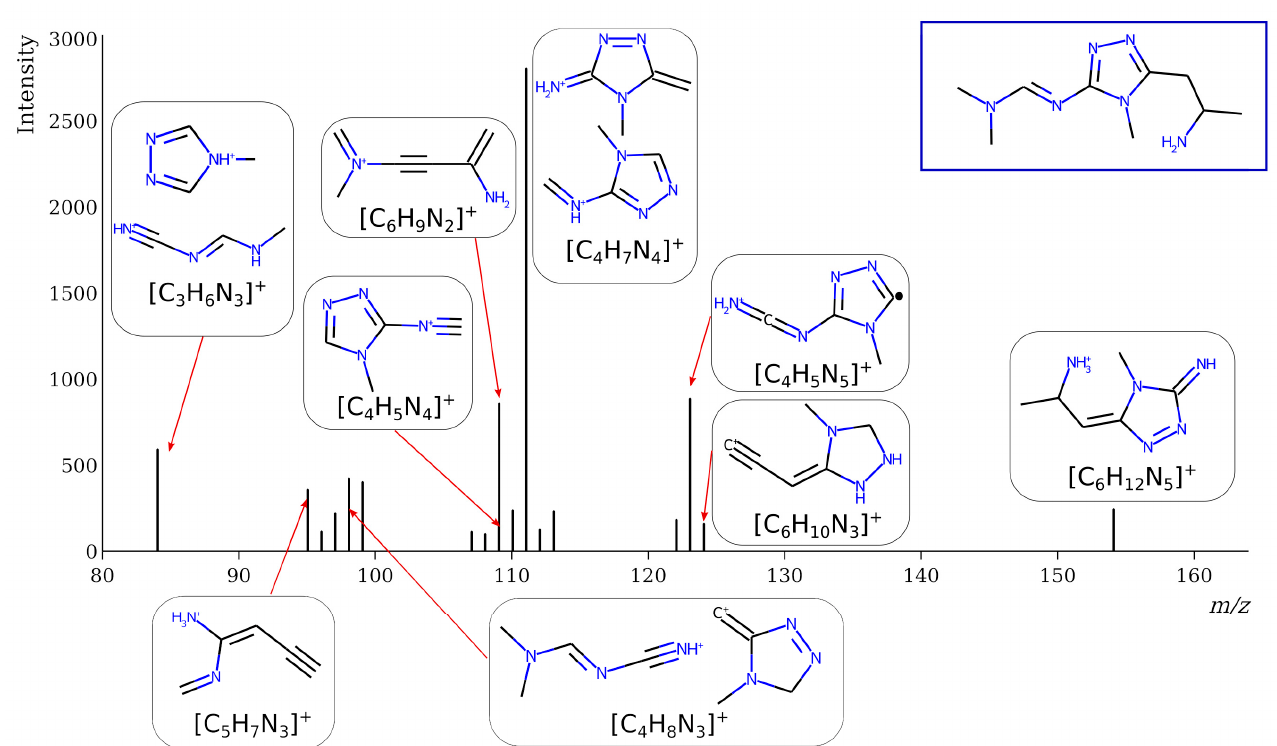
Figure 1. MS 2 (tandem) mass spectrum and the proposed structure of a newly identified unsymmet- rical dimethylhydrazine transformation product. Intensity is given in counts (instrument-dependent arbitrary units); m / z means mass-to-charge ratio.